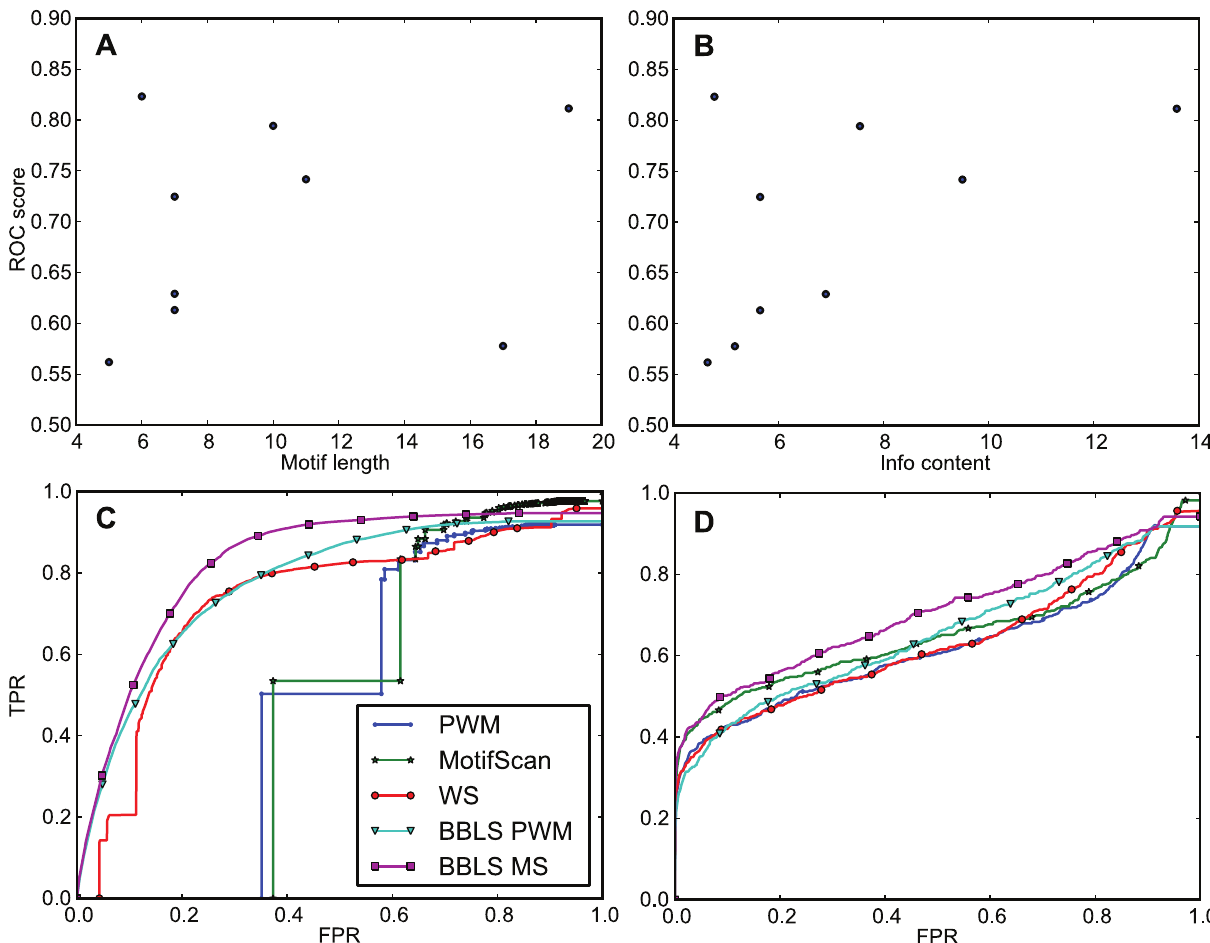
Figure 3. ROC score correlates with motif length and information content. A ) ROC score for PWM scanning as a function of motif length. B ) ROC score for PWM scanning as a function of motif information content. Longer, information-rich motif achieve better scores. Note that YY1 has the second longest motif (V $ YY1_01), but this motif also has the second lowest information content, which likely explains its lower score compared to the most information rich motif (V $ NRSF_Q4). C ) ROC curves for all methods on the E2F4 dataset in the promoter benchmark. The V $ E2F_Q2 motif is one of the least informative motifs and the performance of the prediction methods on the E2F4 dataset is relatively low. D ) ROC curves for all methods on the NRSF dataset in the promoter benchmark. The V $ NRSF_Q4 motif is the most informative motif and the NRSF dataset is among the highest scoring datasets.